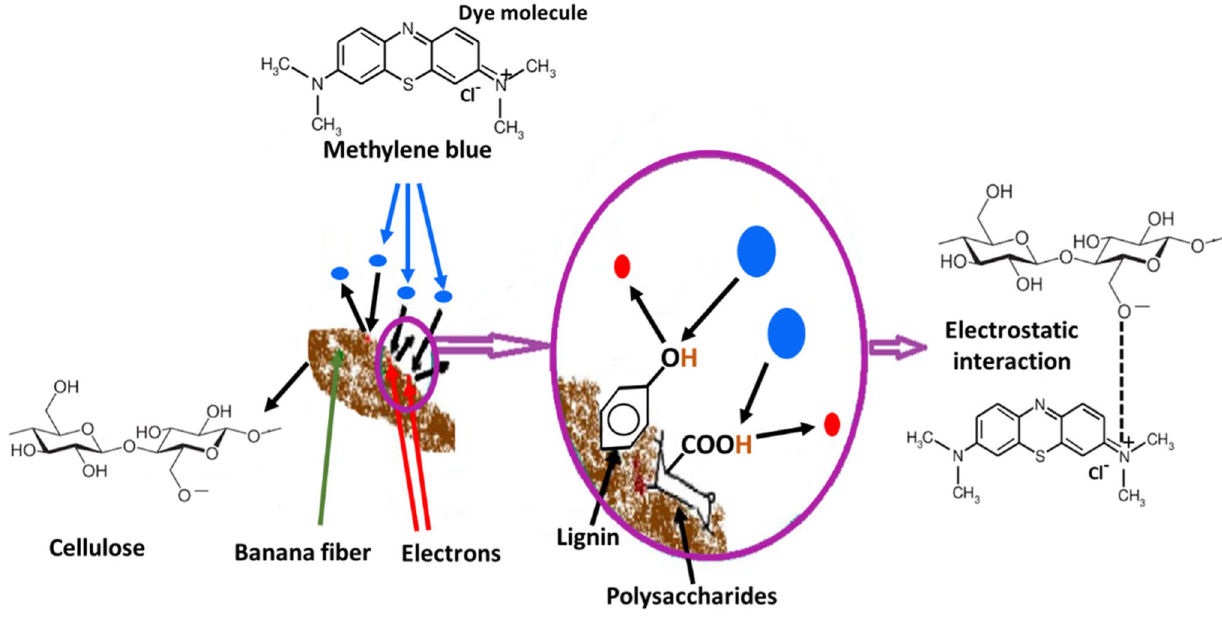
Fig. 15 Plausible adsorption mechanism for the separation of MB dye on the PBF surface